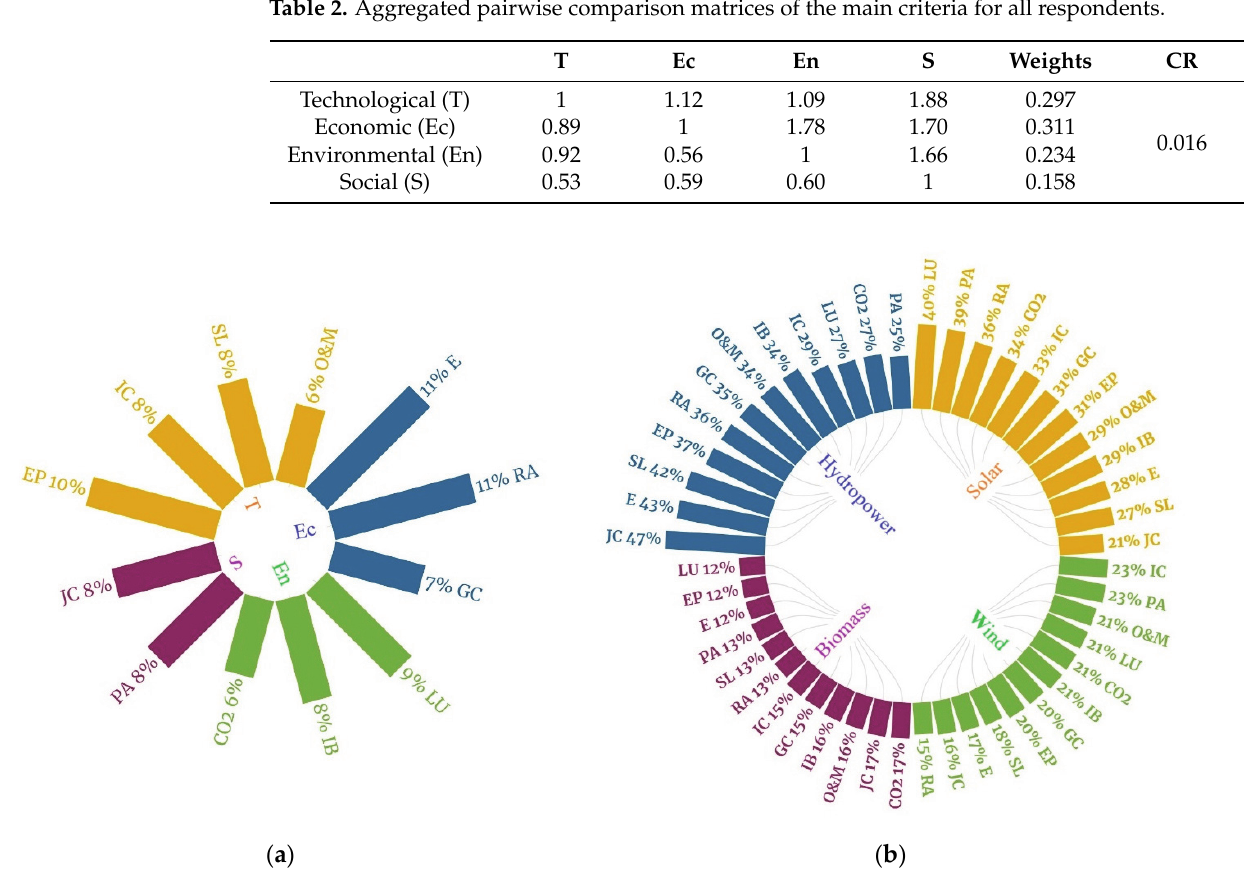
10 of 20 Table 2. Aggregated pairwise comparison matrices of the main criteria for all respondents.